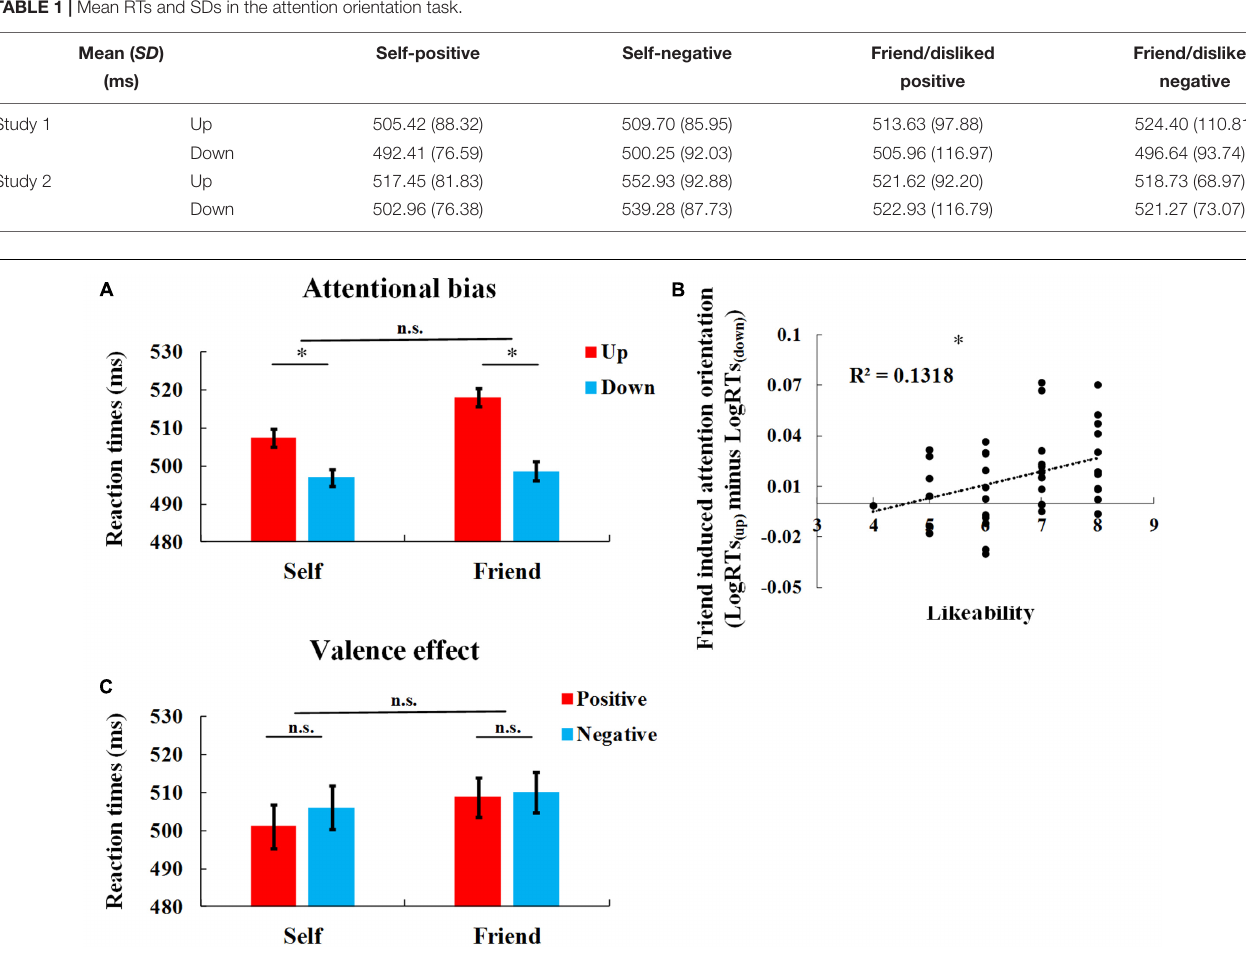
FIGURE 2 | Results of study 1. (A) RTs to targets in different conditions. The RTs are reported in raw millisecond values to facilitate comprehension. Error bars represent within-subject standard error of the mean. (B) Correlation between downward attention orientation effect (lgRT up − lgRT down ) after friend-reflection and the likeability of the friend. (C) RTs to targets after positive and negation reflection. The RTs are reported in raw millisecond values to facilitate comprehension. Error bars represent within-subject standard error of the mean. ∗ p <